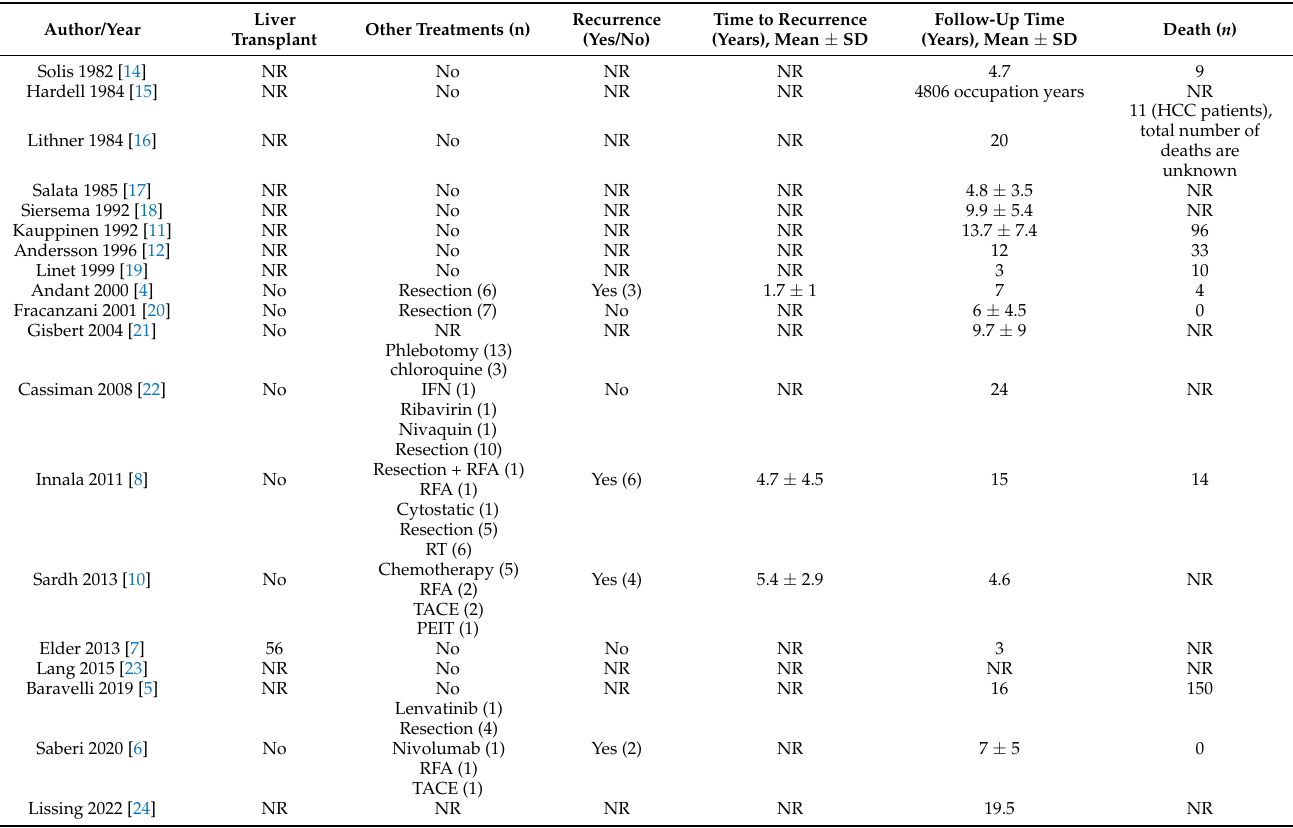
Table 2. Details of treatment and outcomes in patients with